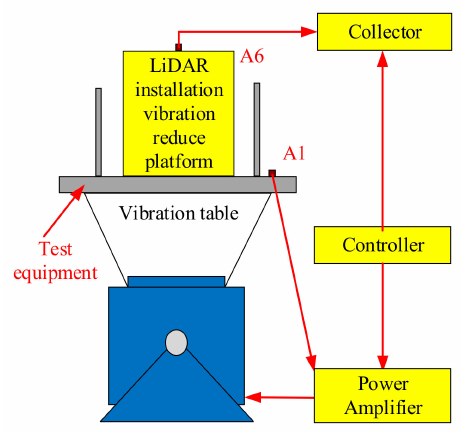
Figure 19. Vibration test.